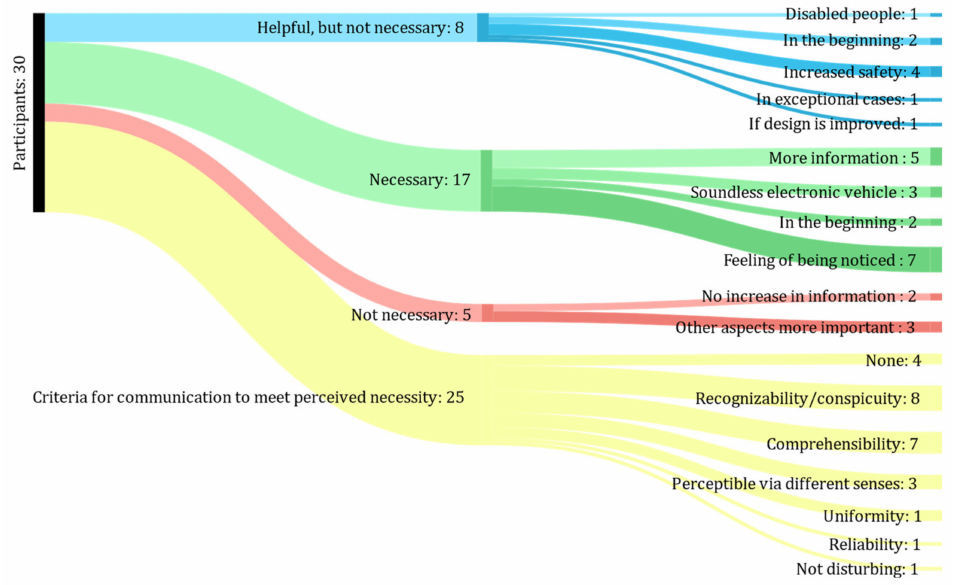
Figure 11. Frequencies of participants’ answers to interview question 4: would you consider external communication as being necessary in automated vehicles? Why [not]? What criteria does external communication have to fulfill in order to meet the stated